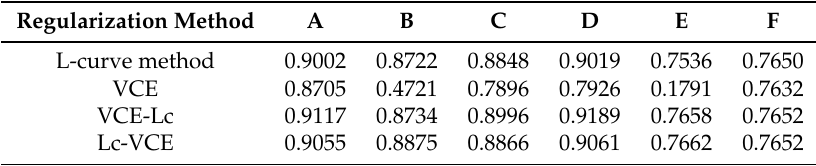
Table 8. Correlations between the estimated coefficients and the validation data of each method using the CuP